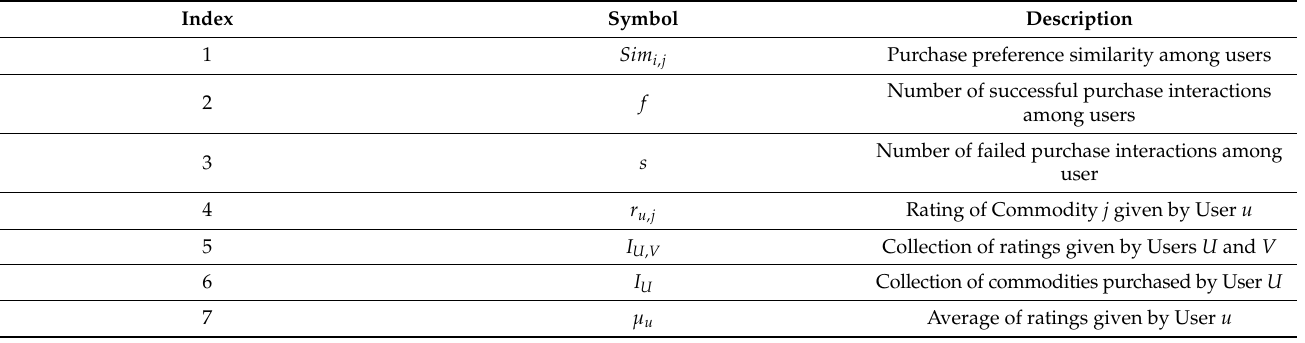
Table 1 is the main symbols used in the formulas in this paper and detailed description. Table 1. Symbols used in formulas and their